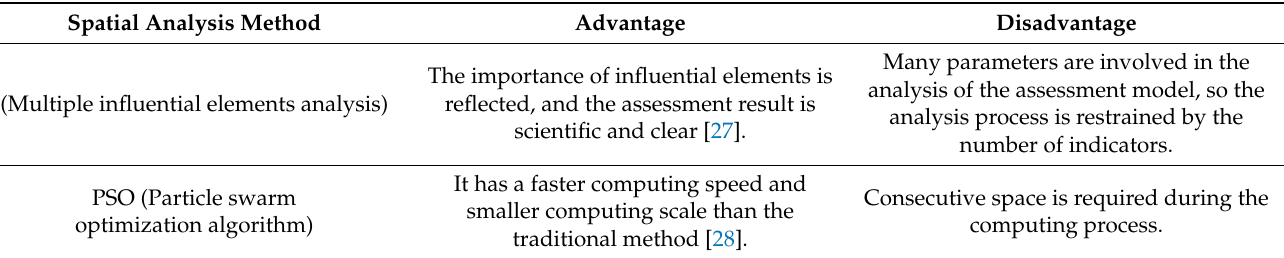
Table 2. Comparison of spatial analysis